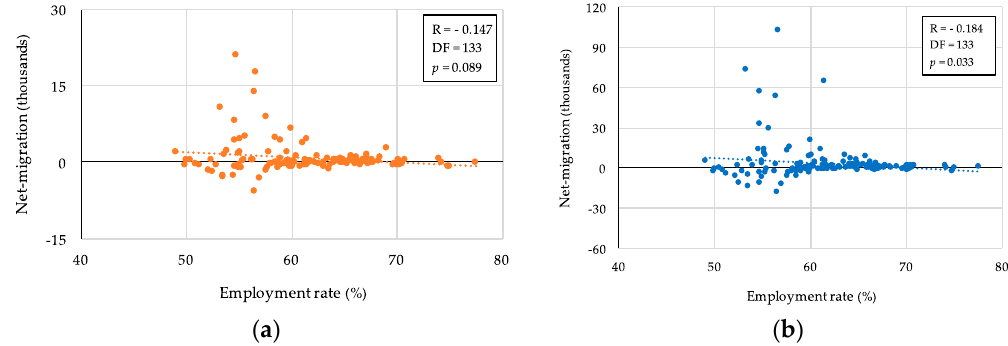
( a ) in 2011; and ( b ) during 2011–2015.